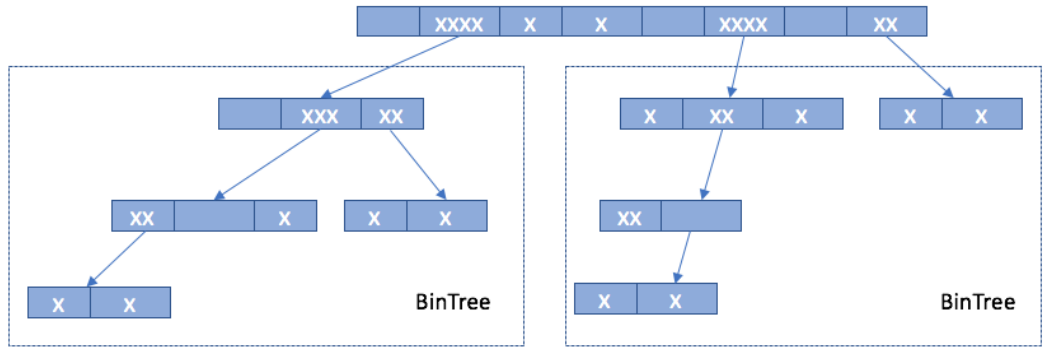
Figure 22. An example of Binary Tree Slotted Aloha (BTSA).